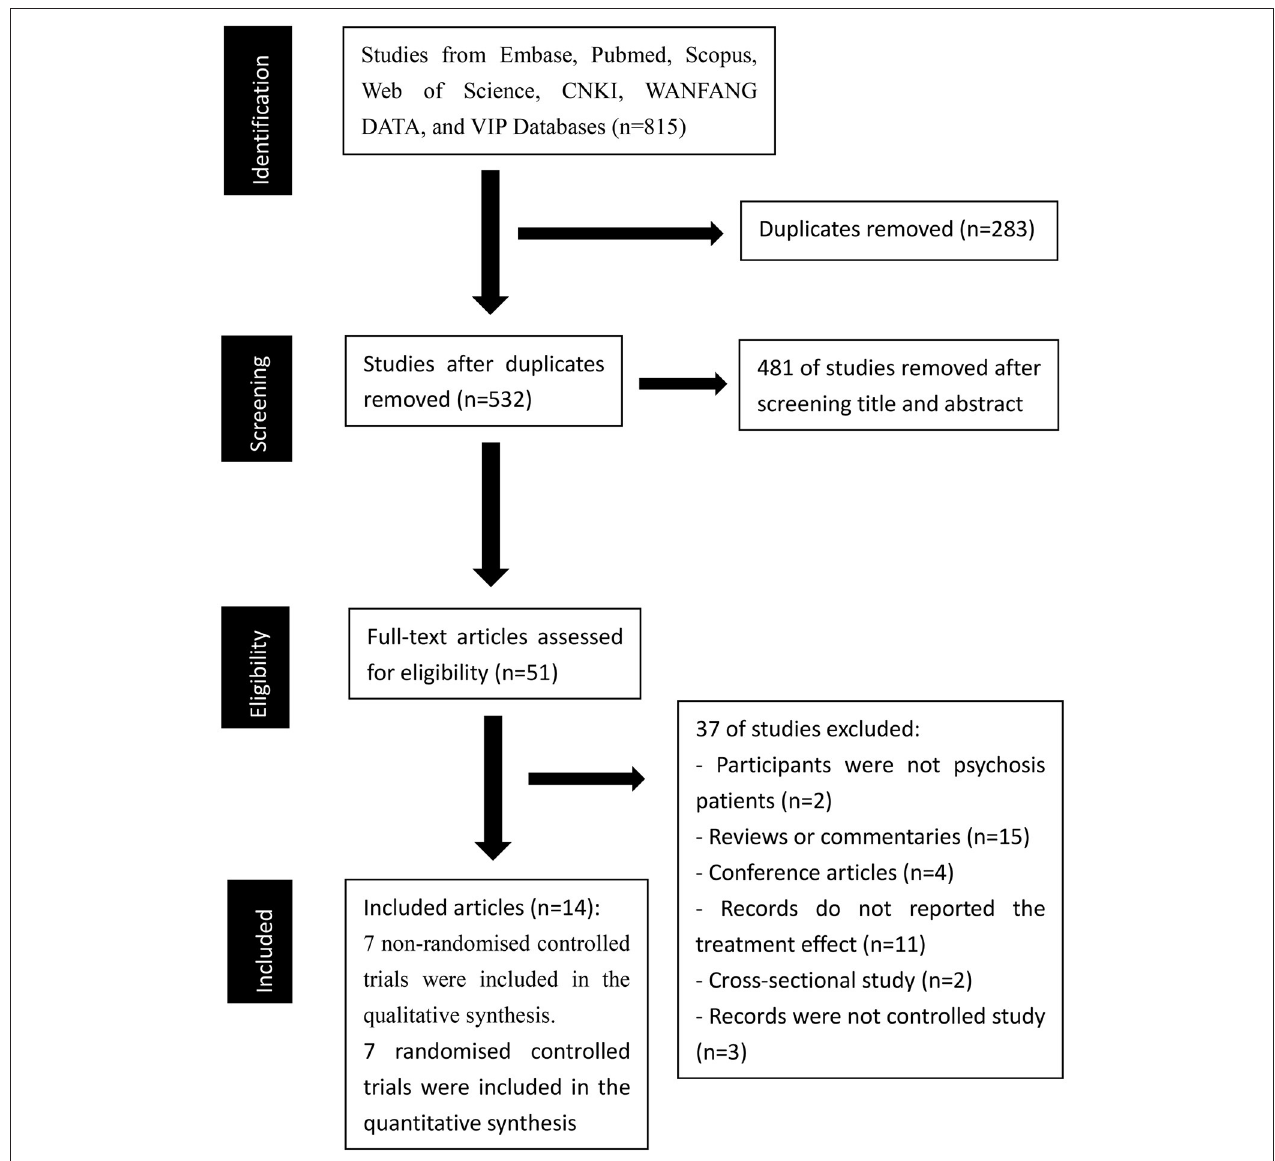
FIGURE 1 | PRISMA diagram of the article selection.